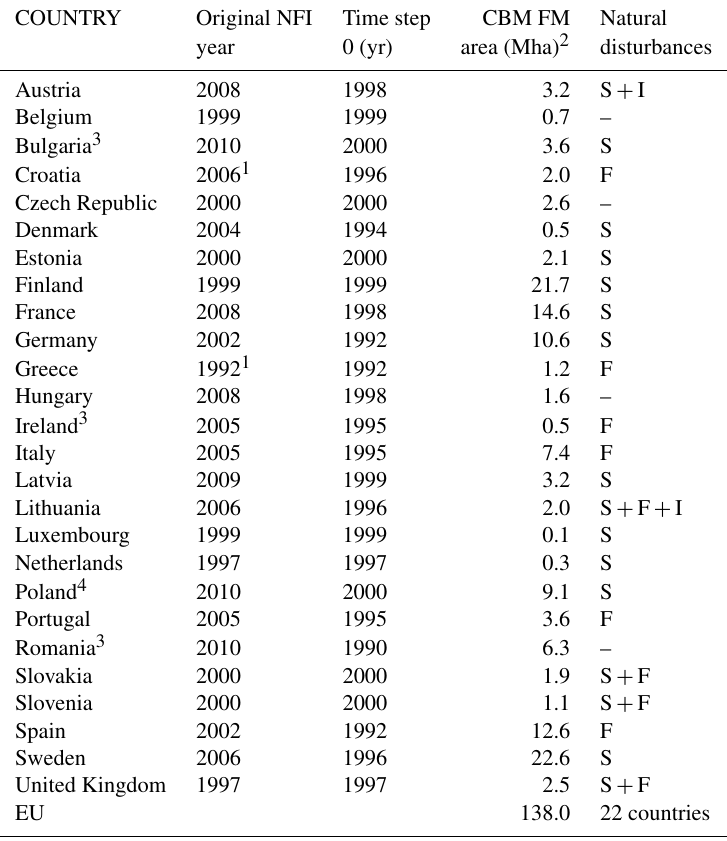
Table 1. Main parameters applied in the Carbon Budget Model (CBM). Detailed information can be found in Pilli et al. (2016a), with the exception of Bulgaria, Ireland, Poland and Romania (see the table’s notes). The table reports the National Forest Inventory (NFI) original reference year; the starting year of model application, the base forest management area (FM, i.e., area of the existing forests in 1990), the additional natural disturbance events considered in the model (F, fire; S, storms and ice sleets; and I, insect